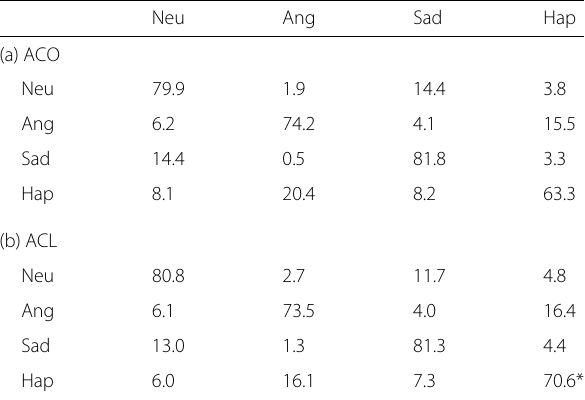
Table 5 Confusion matrix for categorical emotion recognition on the USC EMA database